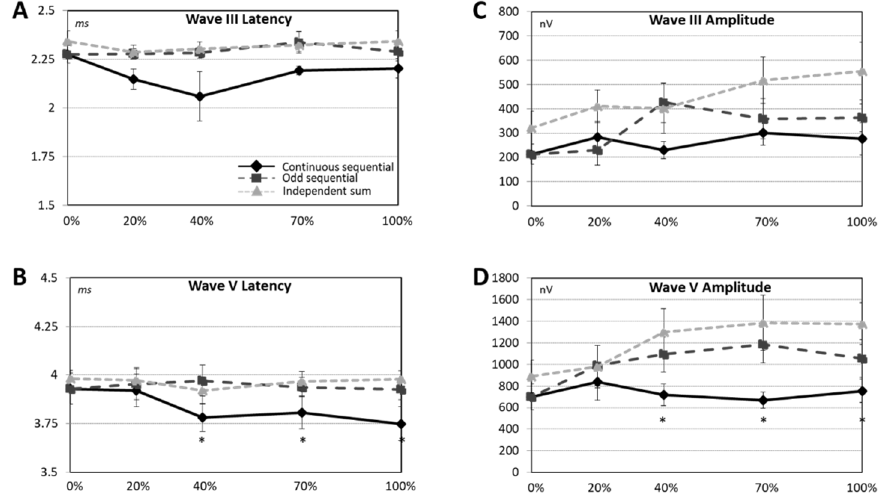
Figure 4. Summary of averaged eABR across subjects and conditions CS, OS, and IS. Wave III and V latencies are shown in panels ( A , B ) while their respective amplitudes are shown in panels ( C , D ). The color code matches those of Figure 3. The asterisks represent the amplitudes showing significant difference during the post hoc analysis.